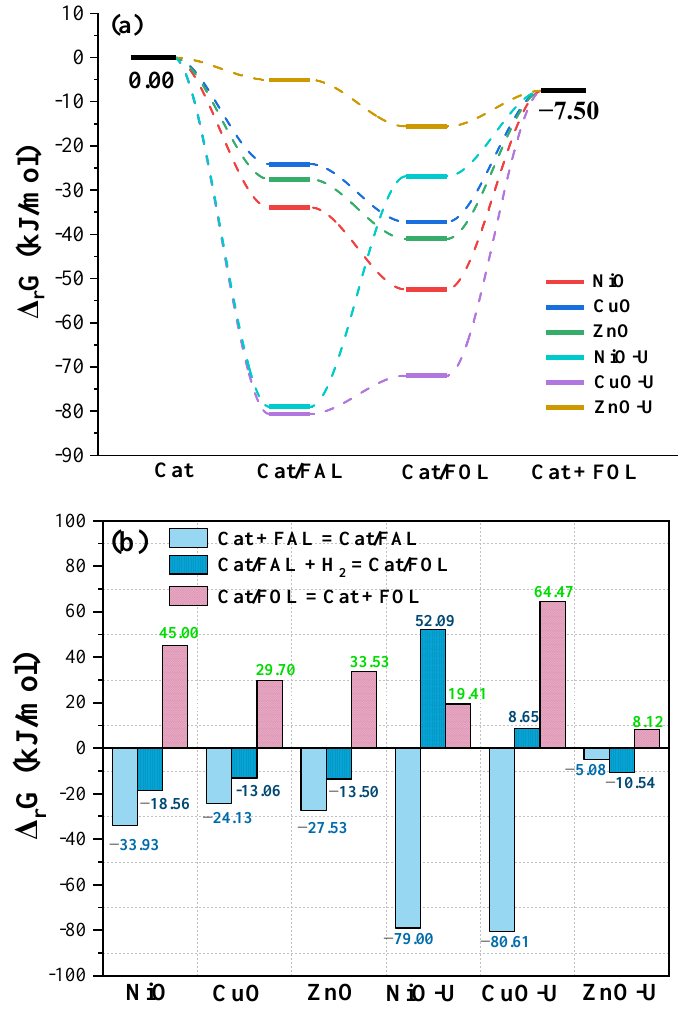
Figure 2. Gibbs free energy (kJ/mol) for all catalysts along the reaction pathway ( a ), together with free energies of adsorption, hydrogenation, and desorption reactions ( b ).